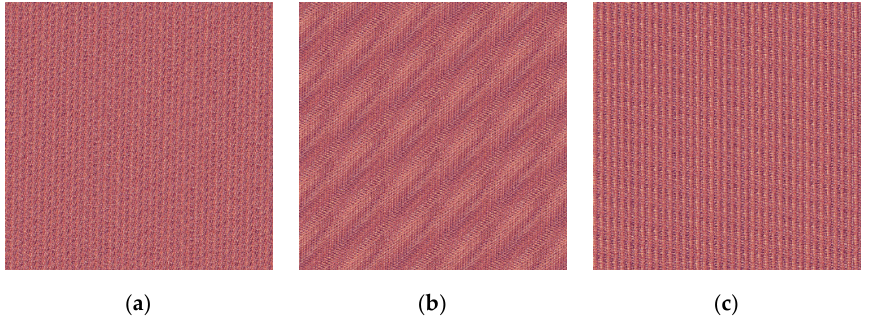
Figure 7. Speech peak frequency is unchanged, and the waveform number is fine-tuned for image decryption. ( a ) Encrypted image when n w 1~ n w 6 are 5, 3, 5, 2, 5, 3; ( b ) Encrypted image when n w 1~ n w 6 are 5, 4, 5, 2, 5, 3; ( c ) Decrypted image that fails after fine-tuning the parameters.